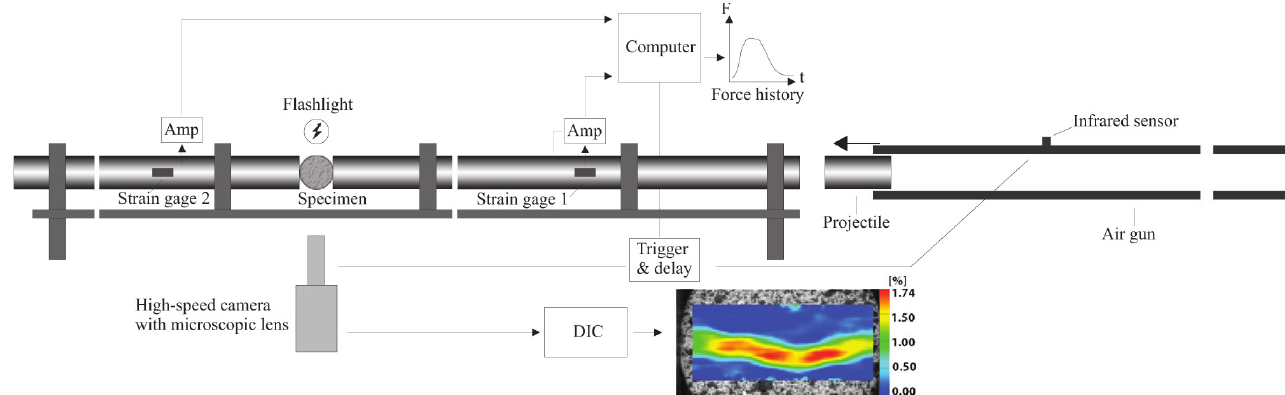
Figure 2. The Split-Hopkinson pressure bar configuration used for the dynamic testing. Here, the set- up is shown for the Brazilian disc test. The setup is essentially the same for the uniaxial compression test but without DIC processing of the